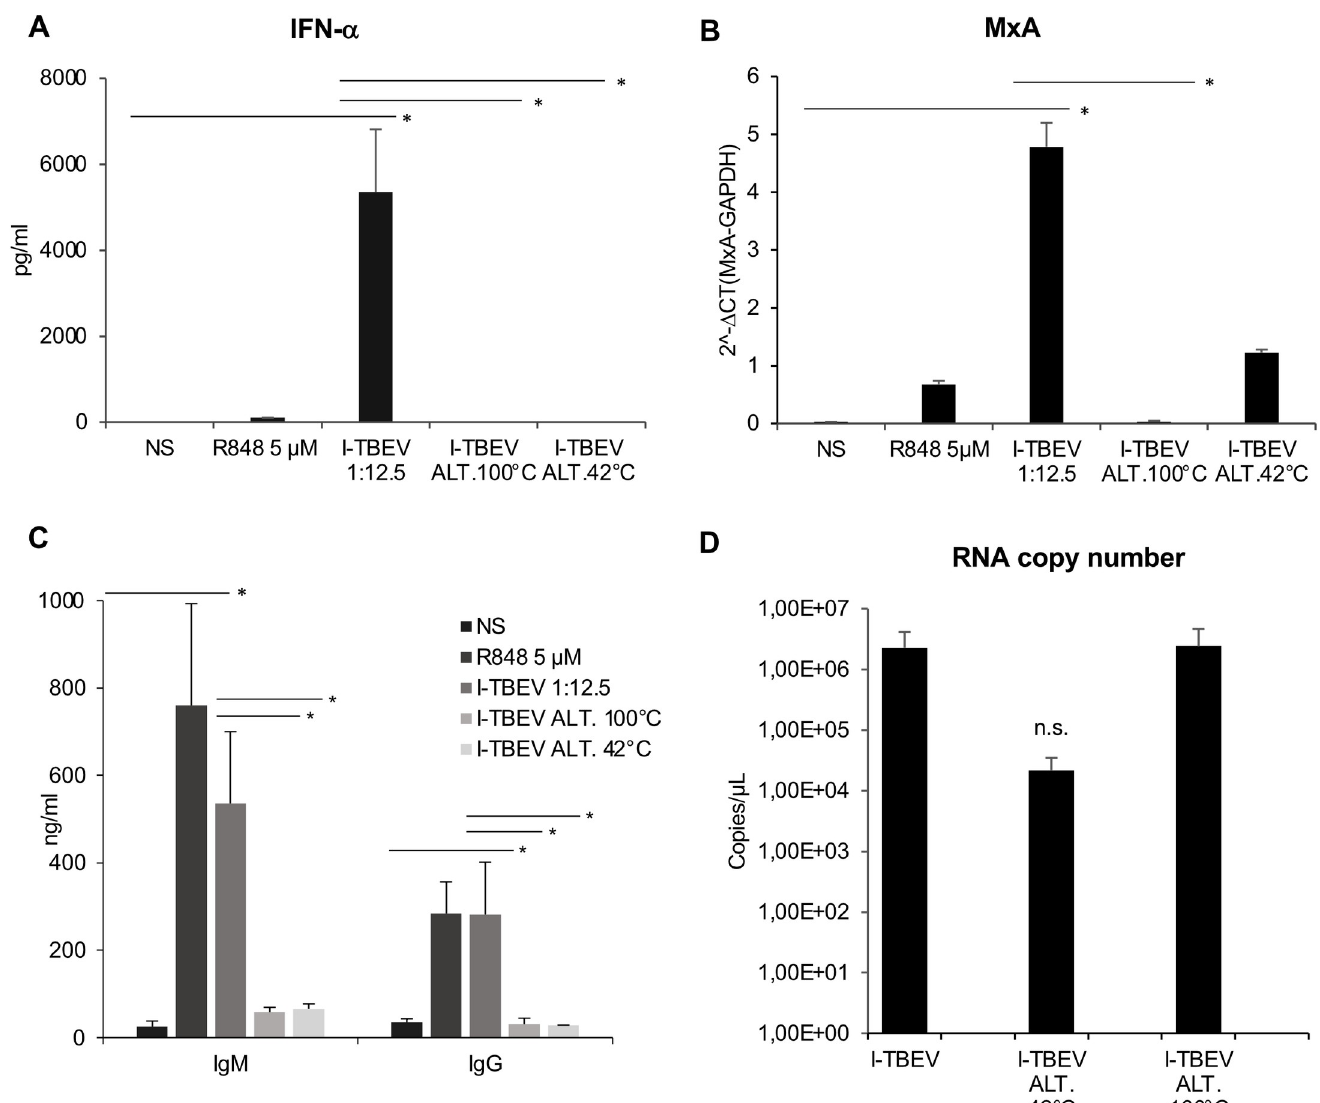
Fig 5. Type I IFN, MxA and Ig expression in PBMC stimulated with I-TBEV altered by temperature. PBMC were left untreated (NS) or stimulated with R848 (5 μ M), I-TBEV (dilution 1:12.5) and I-TBEV altered by treatment for 10 minutes at 100˚C (I-TBEV ALT 100˚C) or for 4 weeks at 42˚C (I-TBEV ALT 42˚C). (A) The production of IFN- α was measured by ELISA in culture supernatants collected after 24 hours. The results shown were mean values ± SEM of 4 independent experiments. ANOVA p value for IFN- α : 0.012. Based on LSD (equivalent to no adjustments). (B) Relative expression of MxA on 24 hours-collected RNA samples was measured by q-PCR analysis. All quantification data are normalized to the GAPDH level by using the equation 2 − Δ Ct . The results shown were mean relative values ± SEM of 3 independent experiments. ANOVA p value for MxA: 0.000. Based on LSD (equivalent to no adjustments). (C) The levels of total IgM and IgG were measured by ELISA in culture supernatants collected after 10 days of stimulation. The results shown were mean values ± SEM of 3 independent experiments. ANOVA p value for IgM: 0.033; for IgG: 0.003. Based on LSD (equivalent to no adjustments). (D) Viral RNA copy number was measured by digital PCR analysis on I-TBEV preparations before and after temperature treatment. The results shown were mean values ± SEM of 2 independent experiments. n.s.: not